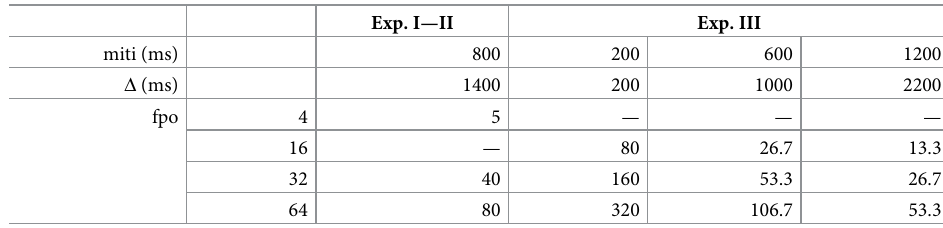
S11 Fig. Hazard rate functions obtained from evidence accumulation model for several val- ues of the parameters. A simple model of evidence accumulation [65] describes activity that accumulates and saturates at target level T . The activity X is updated sequentially according n to: X = X + r ( T − X ) + ε where T < 1 and where ε � N ð 0 ; s 2 Þ are independent ran- n +1 n n n +1 n þ 1 dom variables (Gaussian noise of zero mean and standard deviation σ ). The activity incre- ments are state dependent and proportional to the difference T − X , with constant rate r . n with X near T and the activity can cross the threshold only due to noise. Examples of the effect n of changes in the model parameters. Constant parameters are: T = 0.9, X = 0. When not var- 0 ied, r = 0.7 and σ =